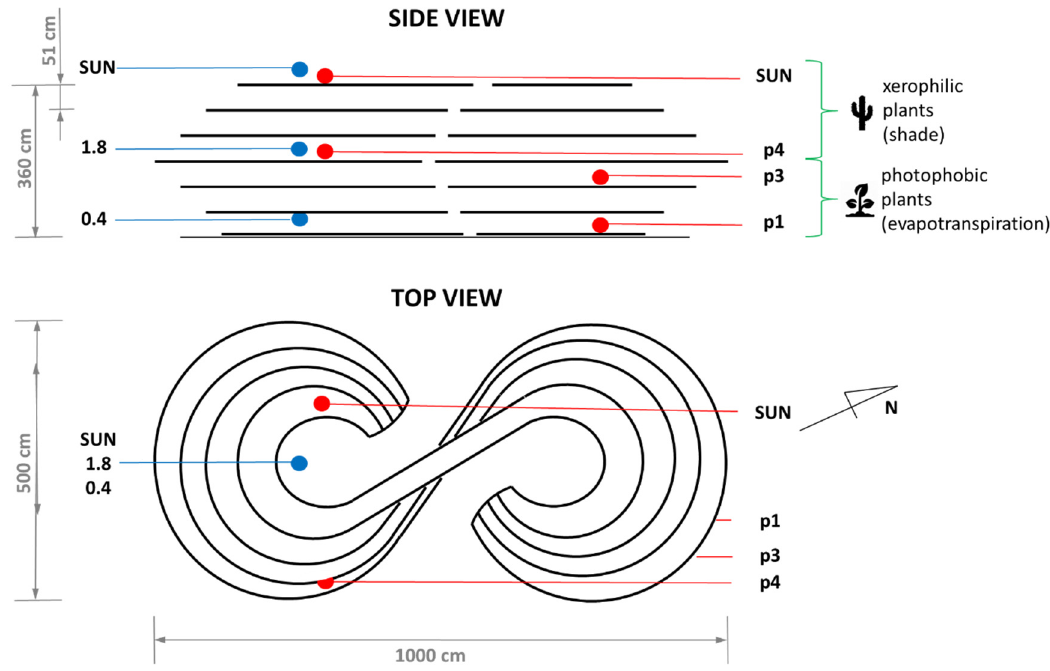
Figure 5. The sketch of The Infinite Green [57] object with sensor location (location in the shelf is approximate): —period A measurements, —period B measurements, the nomenclature is described in Table 1.